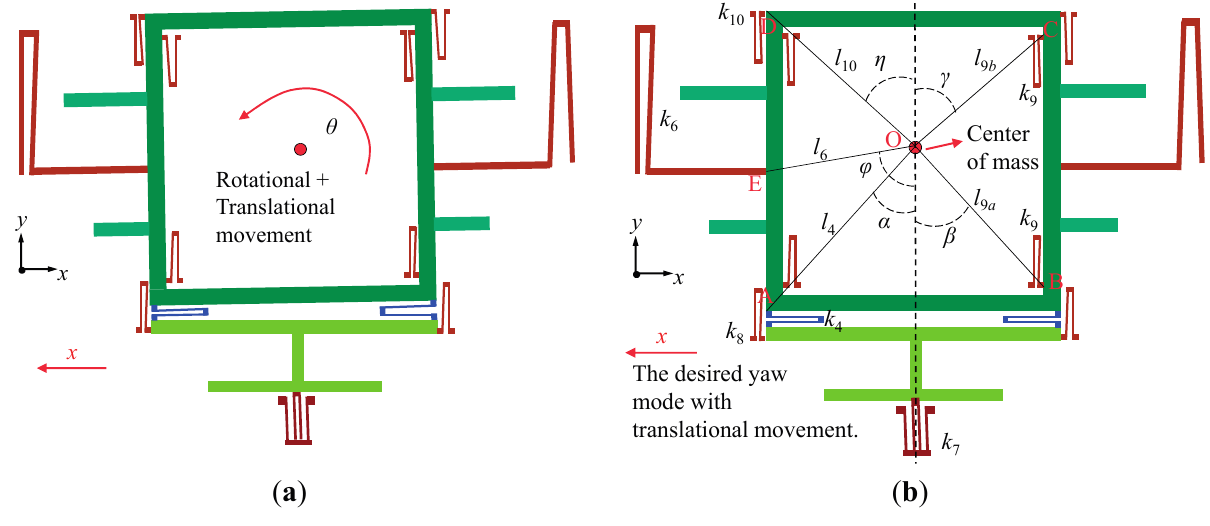
Figure 6. Analysis of the movement in yaw mode. ( a ) The resultant motion including the undesired rotational movement of the big frame. ( b ) The desired translational